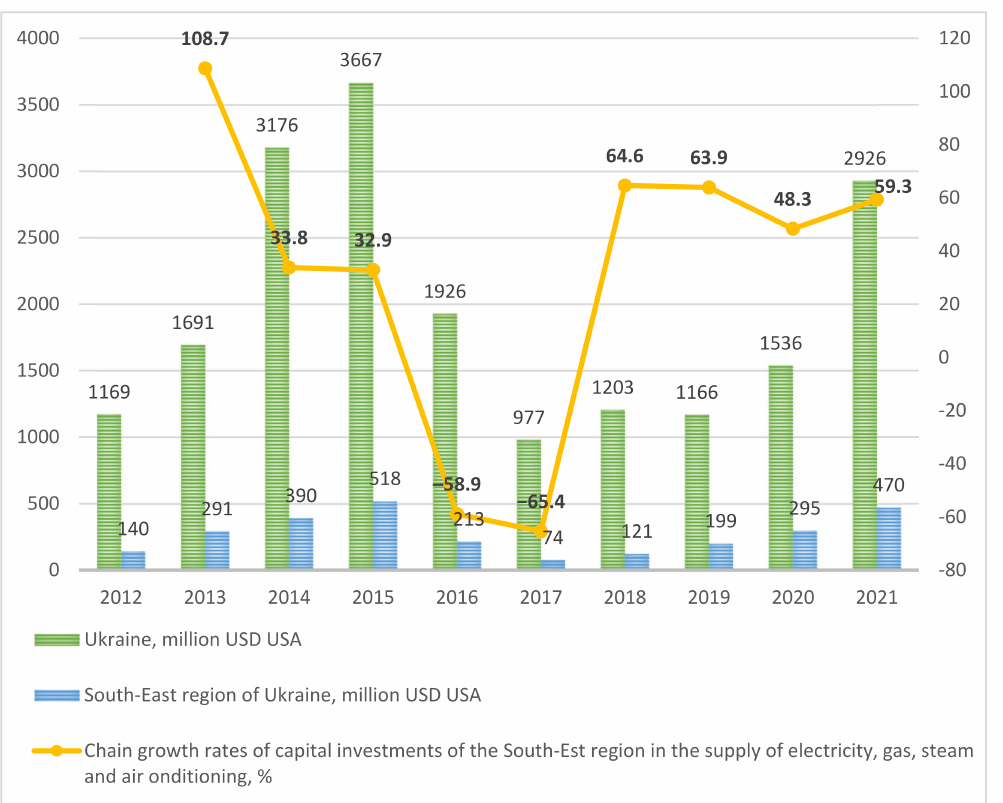
Figure 1. Volumes and chain-growth rates of capital investment inflows in the supply of electricity, gas, steam, and air conditioning in Ukraine and the south-eastern region in 2012–2021, by USD 1 million (constructed by the authors according to the data